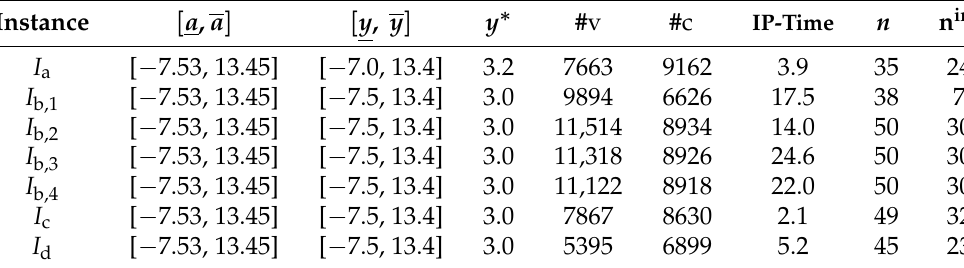
Table 7. Results of Stage 4 for K OW .